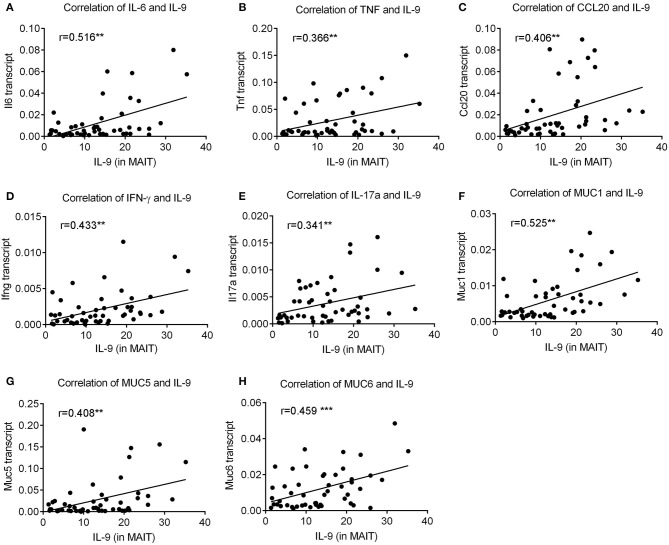
The percentage of IL-9 producing MAIT cells was positively correlated with expressions of pro-inflammatory cytokines and mucus in H. pylori-positive gastritis. The percentage of IL-9+ MAIT cells was determined by flow cytometry (n = 51). The correlations of IL-9+ MAIT cells with gene expressions of (A) IL-6, (B) TNF, (C) CCL20, (D) IFNγ, (E) IL-17a (F) MUC1, (G) MUC5, and (H) MUC6 were analyzed by spearman correlation analysis. **P < 0.01; ***P < 0.001.